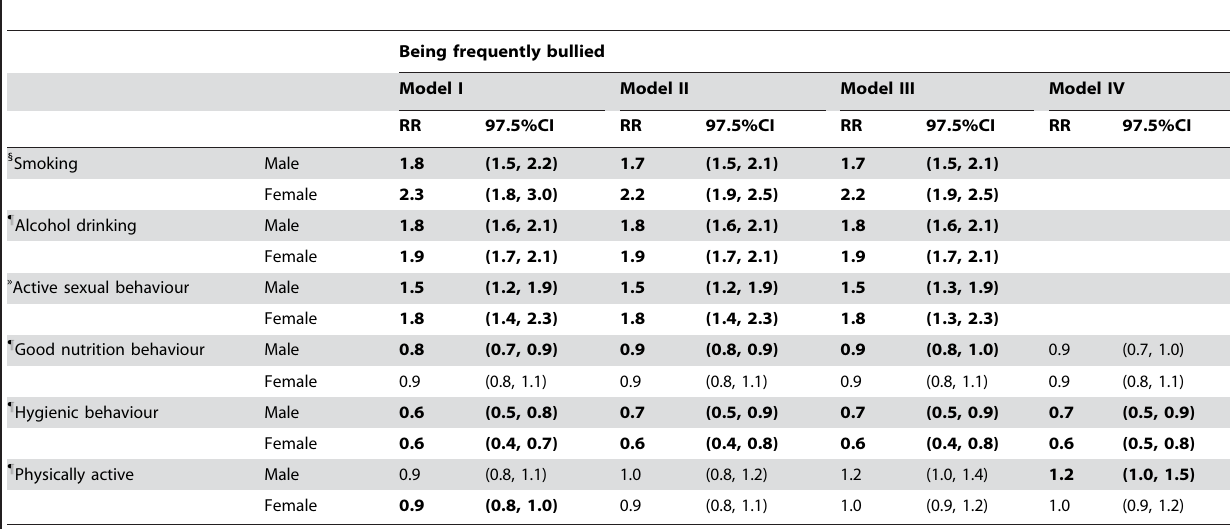
Table 2. Results of multivariate logistic regression analyses for the association of risk and healthy lifestyle behaviours to being frequently bullied among adolescents aged 13–15 years old in 9 countries.